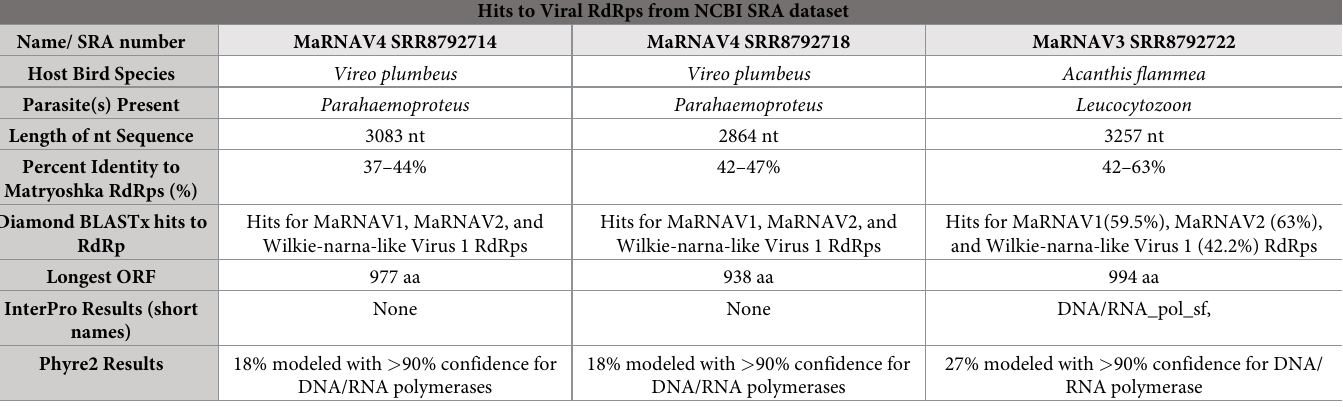
Table 1. Data on specific hits of interest found in the 33 avian blood samples. SRR8792714 & SRR8792718 hits had > 98% similarity, so we decided to use the longest ORF to represent as a single viral